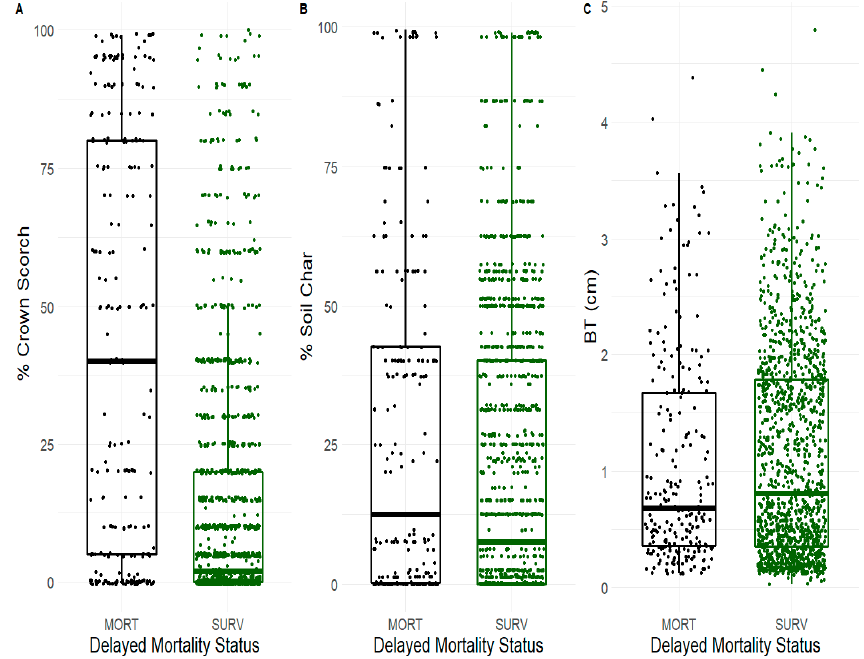
Figure 2. Boxplots showing wide separation between mortality and survivor trees in crown scorch percent ( A ) relative to soil char ( B ) and bark thickness ( C ). Points are randomly jittered for display purposes. N = 1569 trees.